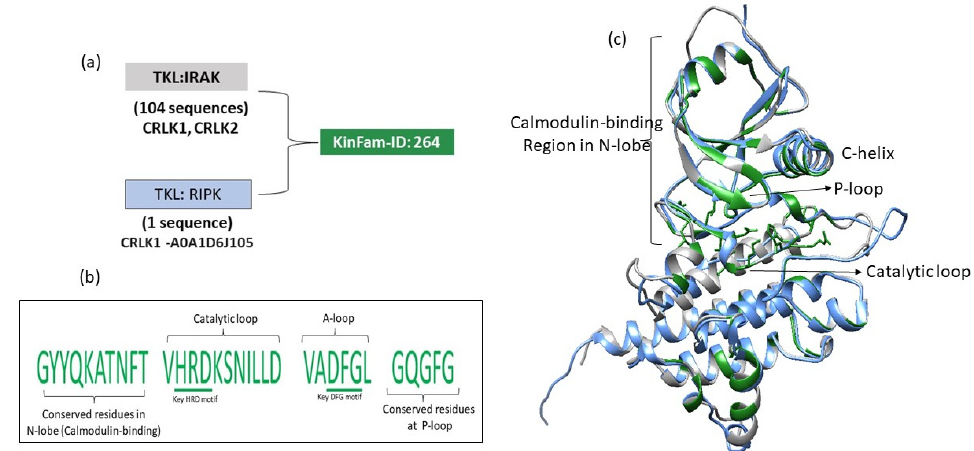
Figure 11. An example illustrating the merging of members of distinct families by the FunFam- MARC protocol. ( a ) KinFam-264 comprises 104 sequences from the KinBase TKL-IRAK family including calcium/calmodulin-regulated receptor-like kinases from plants (CRLK1 and CRLK2, e.g., UniProt ID: Q9FIU5). KinFam-264 merges a singleton sequence from TKL-RIPK, i.e., CRLK1 from Zea Mays [UniProt ID: A0A1D6J105]. ( b ) Closer inspection of conserved sites (shown in green) identified by Scorecons [39] indicates that many (91%) of the highly conserved residues (sites with Scorecons ≥ 90) in the larger group were shared by the singleton sequence. Conserved sites that are in the key functional regions are indicated in the figure-b. ( c ) The conserved sites are depicted using al- phafold2 structures from TKL: RIPK (UniProt ID: A0A1D6J105, blue), and from the representative from TKL: IRAK (Q9FIU5, grey). The key regions are annotated. The majority of conserved sites are located in the N-lobe (known to harbor the calmodulin-binding site), the catalytic loop, the activa- tion loop and the substrate binding site.